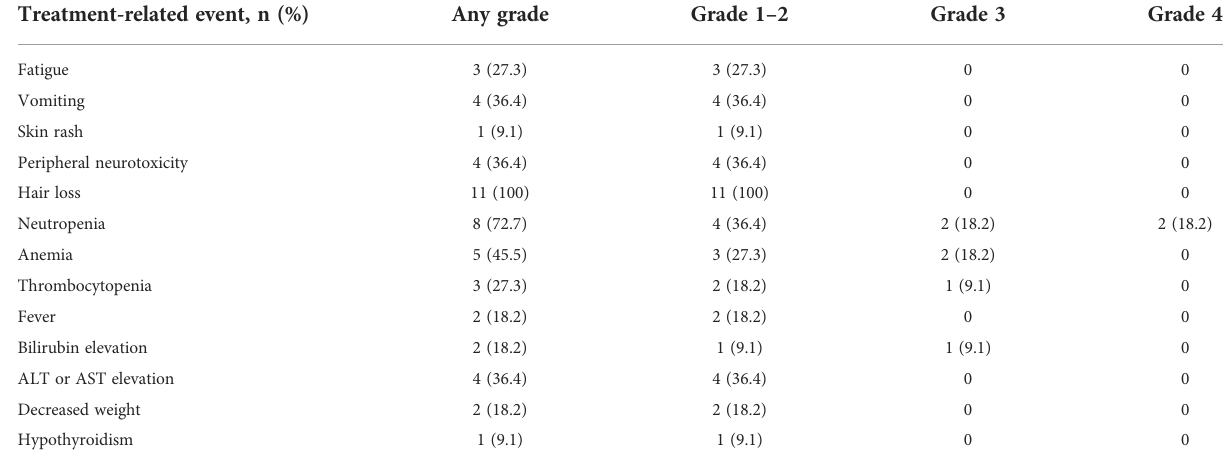
TABLE 4 Treatment-related adverse events in 11 patients. Treatment-related event, n (%) Any